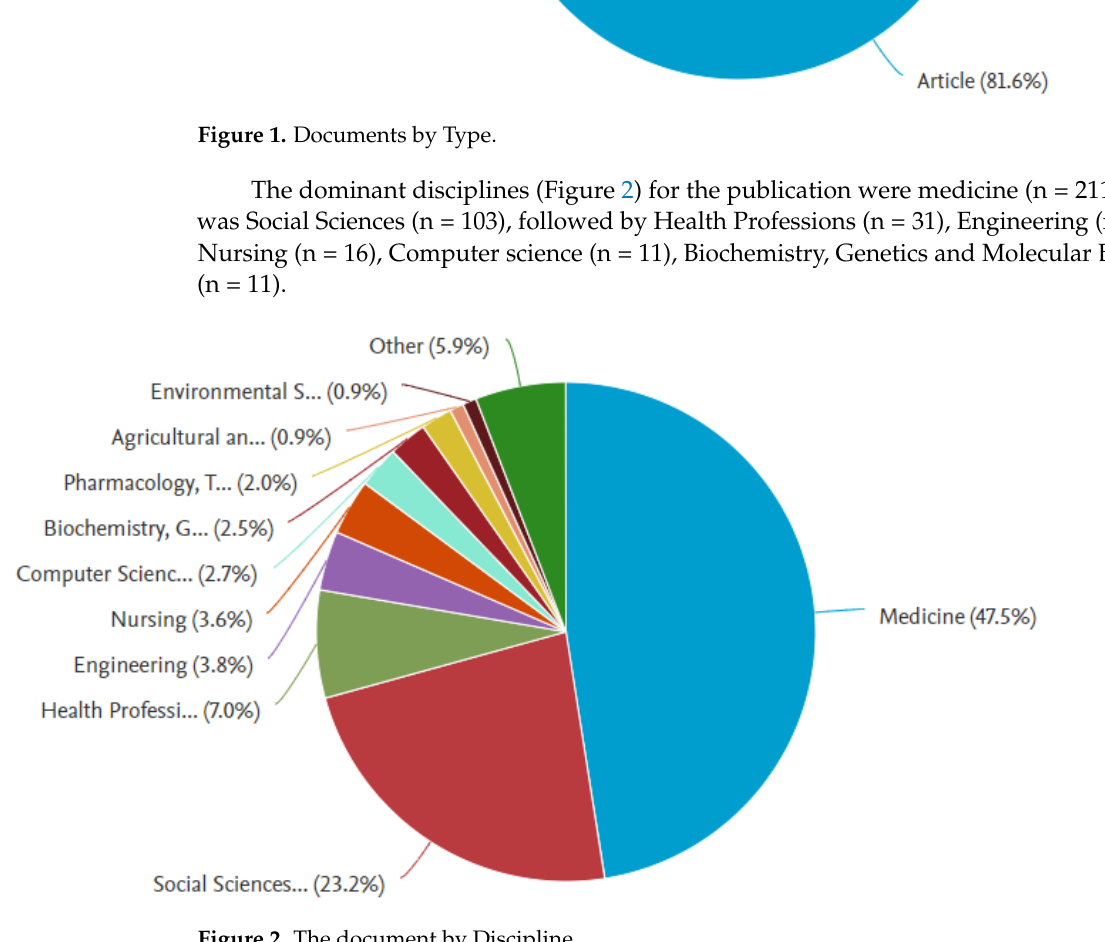
Figure 2. The document by Discipline.